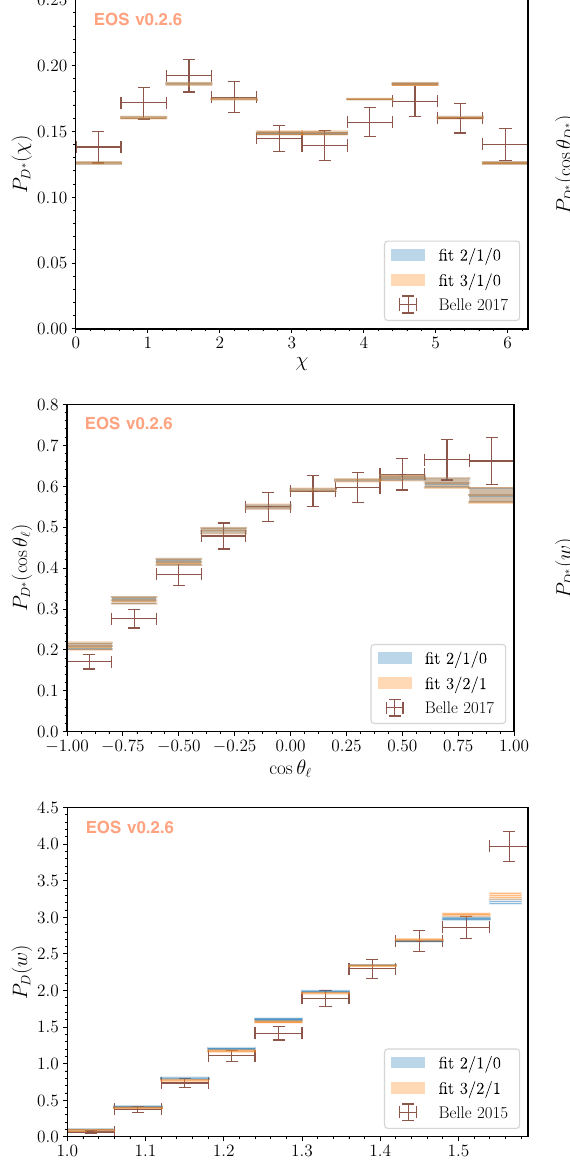
Fig. 2 The four 1D kinematical probability distributions arising from the full 4D differential decay rate ¯ B → D ∗ { e − ,μ − }¯ ν next to one of the 1D kinematical distribution in ¯ B → D { e − ,μ − }¯ ν decays. We show all available constraints published by the Belle collaboration along side